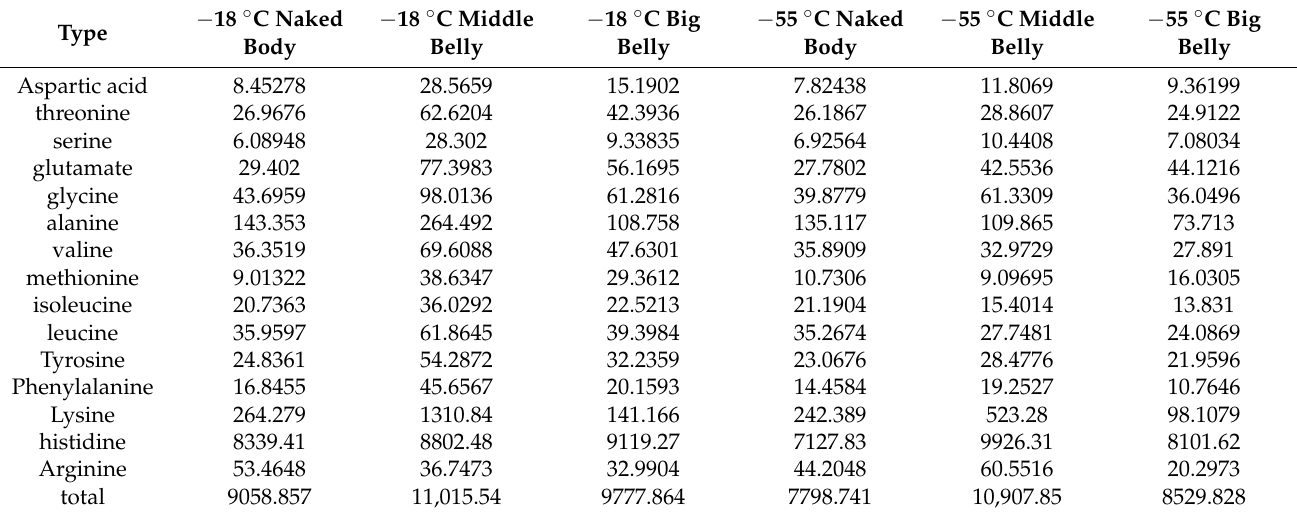
Table 1. Contents of FAAs in different parts of tuna frozen at different